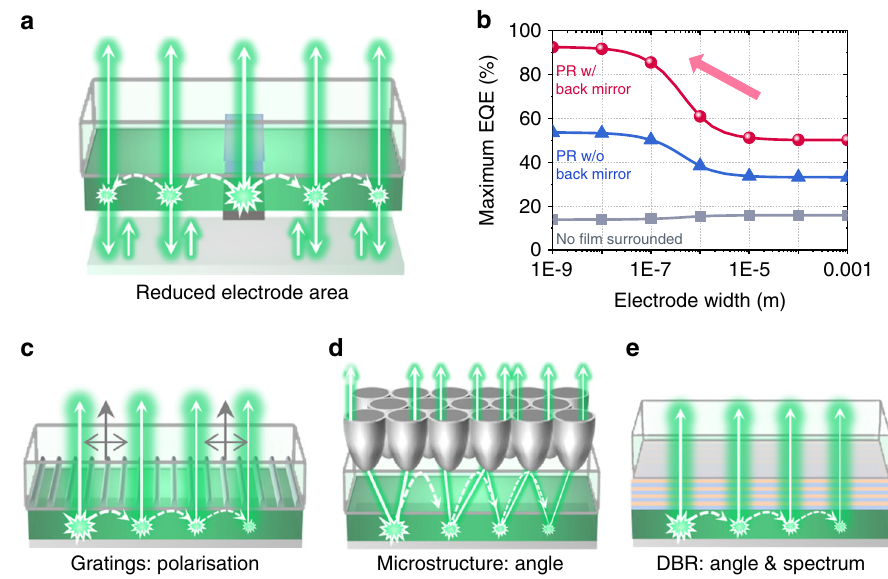
Fig. 4 Photonic structure control of PR. a A proposed LED architecture consisting of small area electrodes and a large area fi lm, having a re fl ecting mirror at the bottom. b Calculated maximum EQE (IQE = 100%) as a function of electrode width in the proposed systems having PR with back mirror, PR without back mirror (only front re-emission is collected) and no fi lm surrounded (PR only occurs inside the pixel). The device structure in the electrode-covered area was assumed to be same as the one for Fig. 3 (with a 50 nm-thick PEA 2 Cs n-1 Pb n Br 3n + 1 perovskite). c – e Examples of light property modi fi cation using